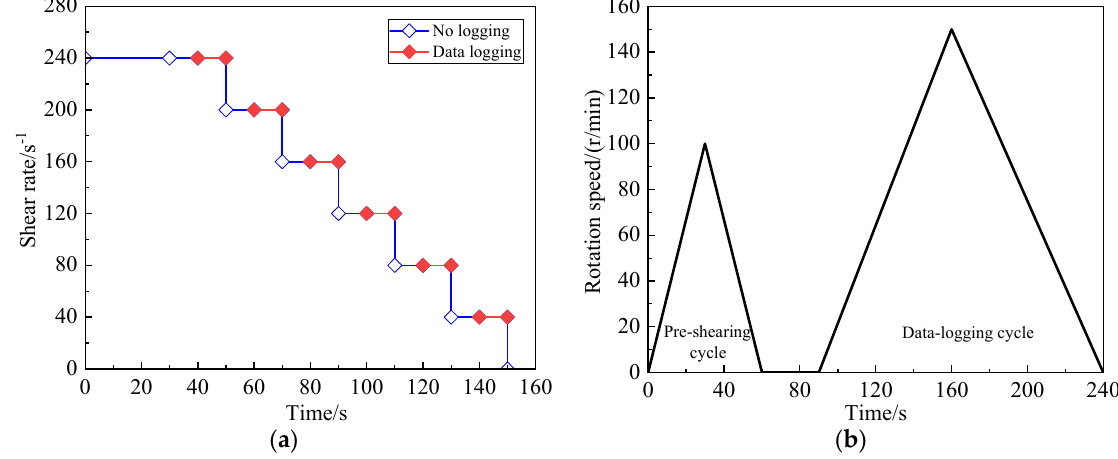
Figure 2. Testing protocol of shear curves. ( a ) Step shearing [40] ( b ) linearity shearing [8].